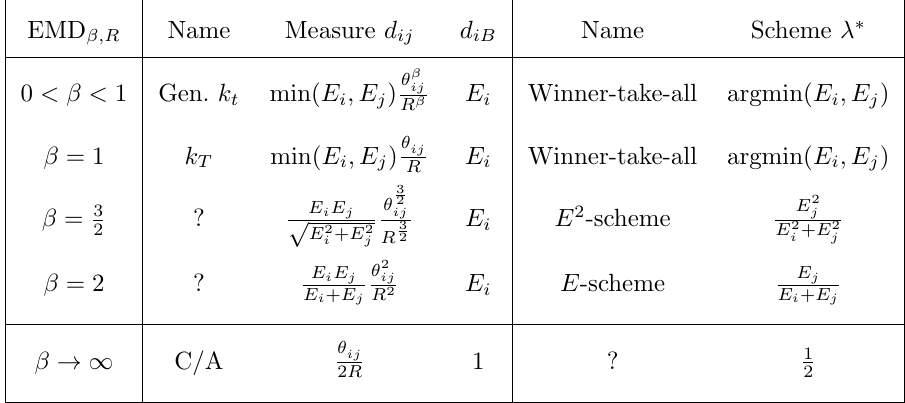
Table 5 . Di(cid:11)erent sequential recombination measures d ij and recombination schemes (cid:21) (cid:3) that emerge from an EMD formulation. A question mark indicates a method that, to our knowledge, does not yet appear in the literature. The traditional de(cid:12)nitions of generalized k t and C/A require squaring d ij and d iB . Note the factor of 2 in the C/A e(cid:11)ective jet radius